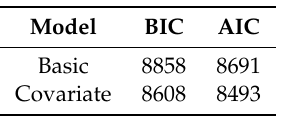
Table 2. Model Selection